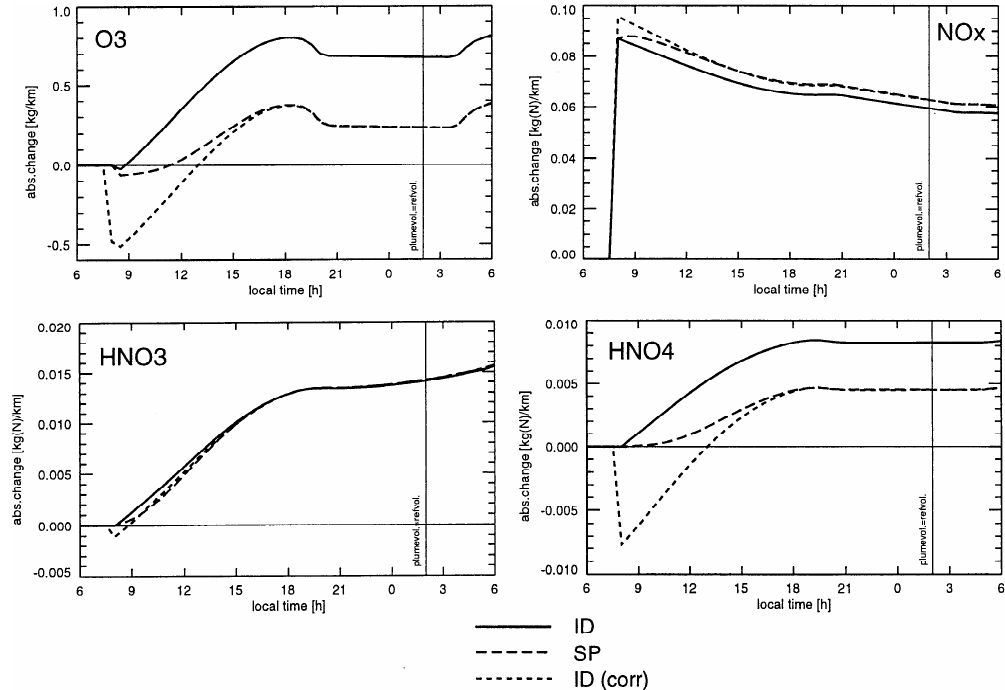
Fig. 9. Absolute changes (kgkm − 1 ) of some key species caused by emission of a B-747, released at 08:00local time into an unpolluted atmosphere with plume lifetime is τ = 18h. Reprinted from Petry et al. (1998). An edited version of this paper was published by AGU. Copyright (1998) American Geophysical